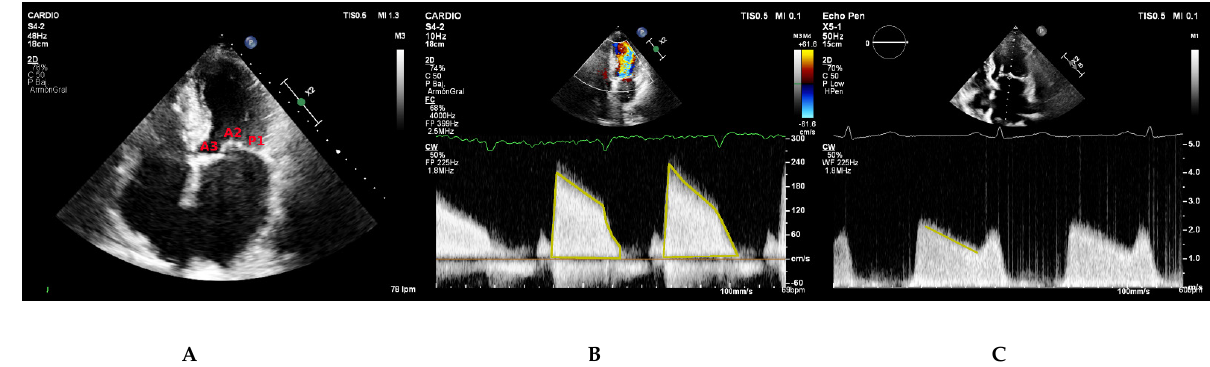
Figure 4. ( A ) Apical four chamber view depicting the P1, A2, and A3 mitral scallops. ( B , C ) Continuous wave Doppler